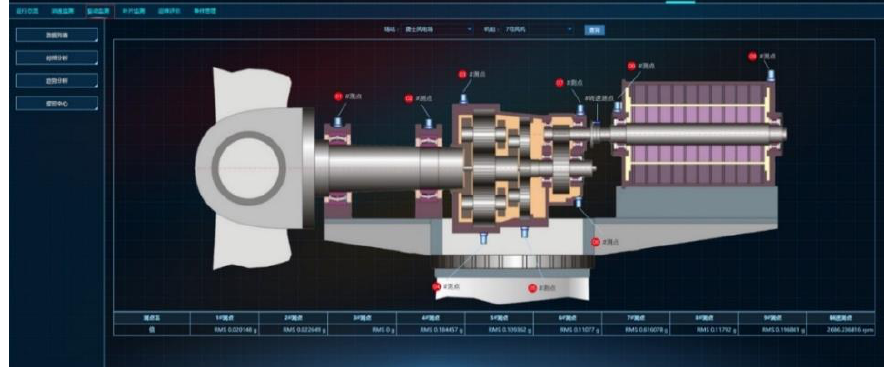
Figure 7. Fault diagnosis module of the monitoring system.